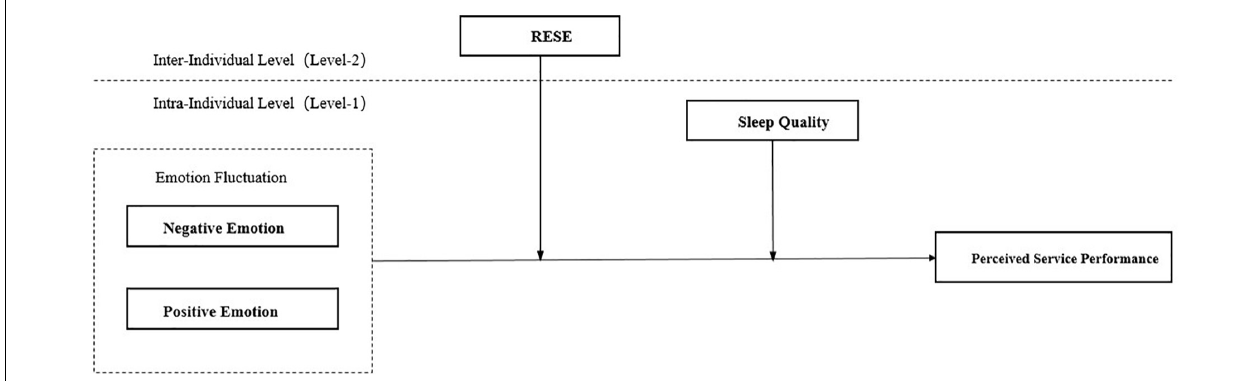
FIGURE 1 | Theoretical research